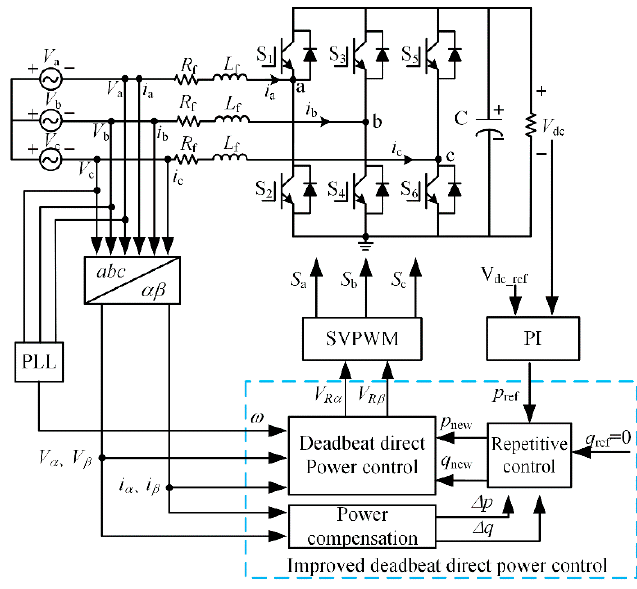
Figure 1. Control system block diagram.